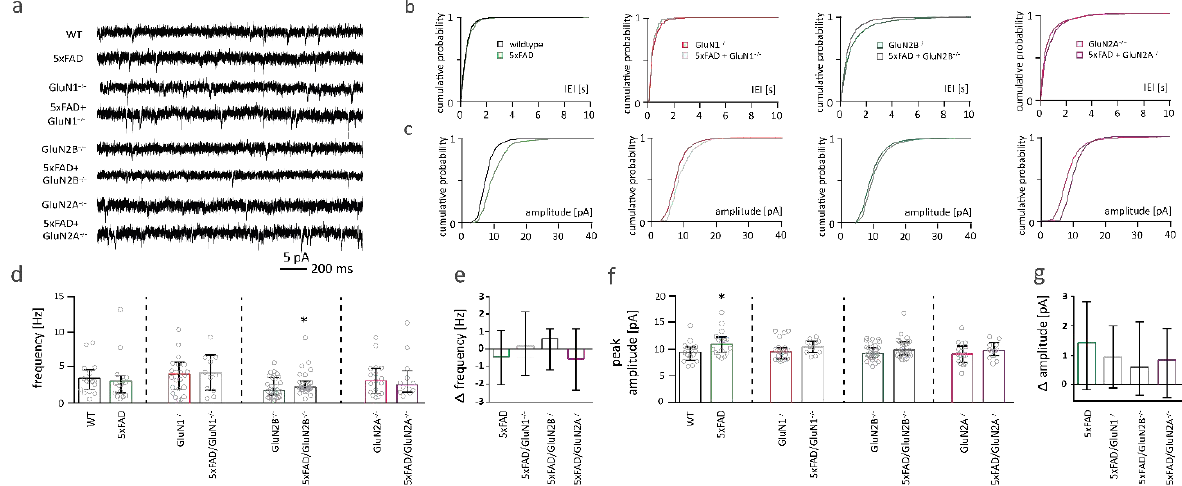
Figure 4. Functional synapses are only mildly affected in pyramidal cells of the somatosensory cortex from 5xFAD mice. ( a ) Sample traces of miniature excitatory postsynaptic current (mEPSC) recordings. ( b ) Cumulative distribution plots of the median inter-event-intervals (IEI) of mEPSCs of pyramidal cells of the somatosensory cortex. ( c ) Cumulative distribution plots of the median amplitudes of mEPSCs. ( d ) Bar graphs of mEPSC frequencies neurons of wildtype (WT) ( n = 16) and 5xFAD ( n = 16) mice (left), with deletion of GluN1 (middle left) ( n = 22 GluN1 −/− vs. n = 11 5xFAD/GluN1 −/− ) or GluN2B (middle right) ( n = 32 GluN2B −/− vs. n = 30 5xFAD/GluN2B −/− ) or GluN2A (right) ( n = 17 GluN2A −/− vs. n = 12 5xFAD/GluN2A −/− ). ( e ) Bar graph showing the change in mEPSC frequency in pyramidal cells from 5xFAD mice when compared to the respective control mouse (WT, GluN1 −/− , GluN2B −/− , GluN2A −/− ), quantified from data in ( d ). ( f ) Bar graphs of peak amplitudes of mEPSCs from WT and 5xFAD mice (left) with GluN1 (middle left) or GluN2B (middle right) or GluN2A (right) deletion. ( g ) Bar graph showing the change in mEPSC amplitude in pyramidal cells from 5xFAD mice when compared to the respective control mouse (WT, GluN1 −/− , GluN2B −/− , GluN2A −/− ), quantified from data in ( f ). Data in bar graphs are shown as median ± interquartile range. Empty grey circles depict single data points. Mann – Whitney test/Kruskal – Wallis test: * p < 0.05.